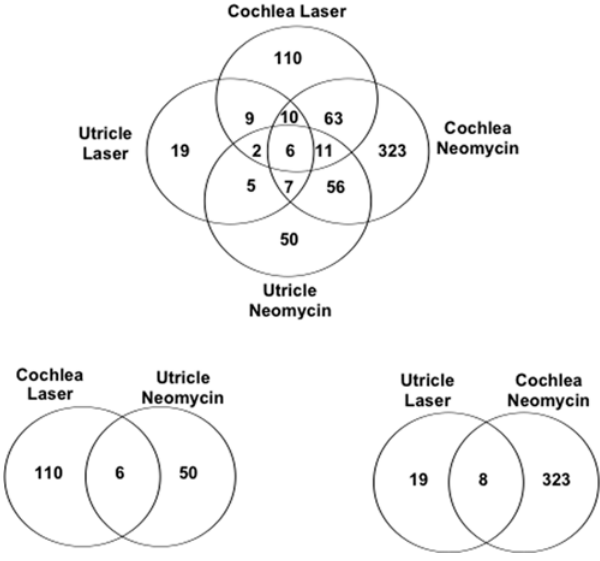
Figure 1. Overlaps between differentially expressed genes in the four treatment/time course combinations. These Venn diagrams illustrate the overlaps between genes that were scored as being either up or down regulated. To be included as an overlap a gene must be differentially expressed in at least one time point in both time courses ( . 1.2-fold and p-value , =0.05), but the time points or trends do not have to necessarily match. For a detailed listing of all of the genes in the overlaps see Supplementary Tables S2, S4, S6 and